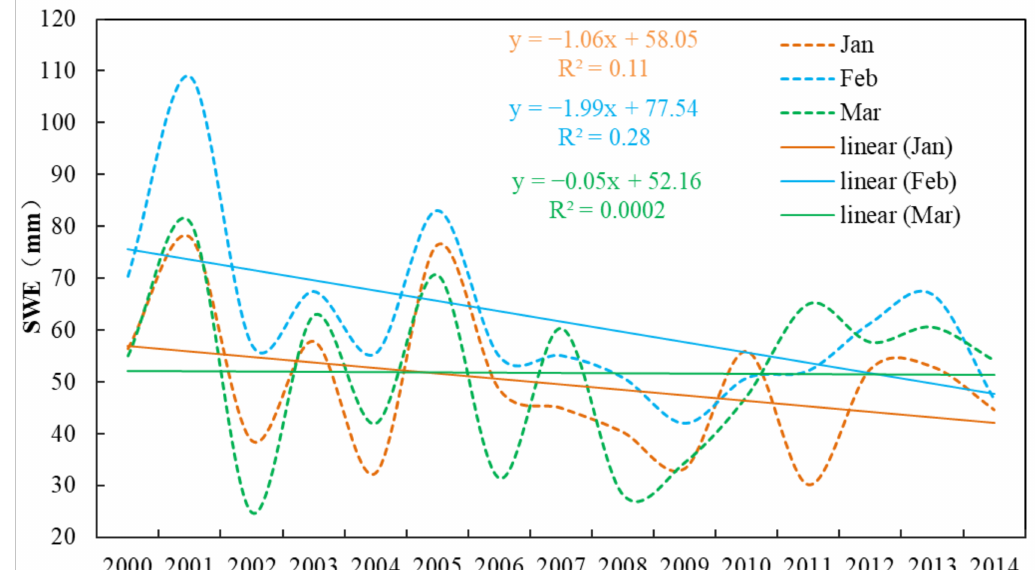
Figure 15. Yearly variations in Snow Water Equivalent (SWE) for the months of January, February, and March and their linear trends for Tengiz Lake